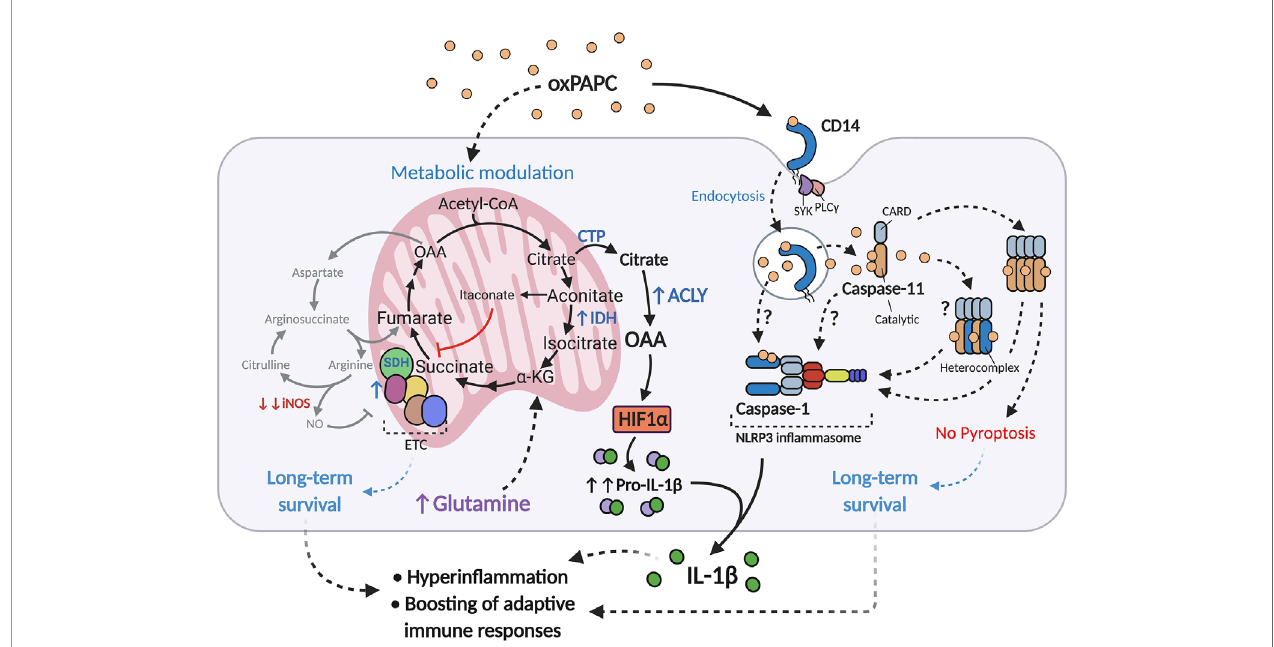
FIGURE 1 | oxPAPC boosts in fl ammatory responses in LPS-activated macrophages. Upon LPS encounter and/or during atherosclerosis development, oxPAPC induces a metabolic remodeling state in phagocytes, termed hypermetabolism, that is characterized by 1) boosting of mitochondrial activity via iNOS inhibition and ETC protection; 2) sustaining the TCA cycle with glutamine and upregulation of IDH; and 3) upregulating ACLY. These events result in the conversion of citrate to OAA, which in turn stabilizes HIF-1 a and increases production of pro-IL-1 b . OxPAPC is also transported into the cytosol via the endocytic module CD14-SYK-PLC g , where it interacts with caspse-11/4 and induces oligomerization of this enzyme. oxPAPC may also interact with caspase-1, to form caspase-11/4/5-1 hetero- complexes, or to activate the NLRP3 in fl ammasome. These processes, termed hyperactivation, lead to IL-1 b cleavage and release, but not to